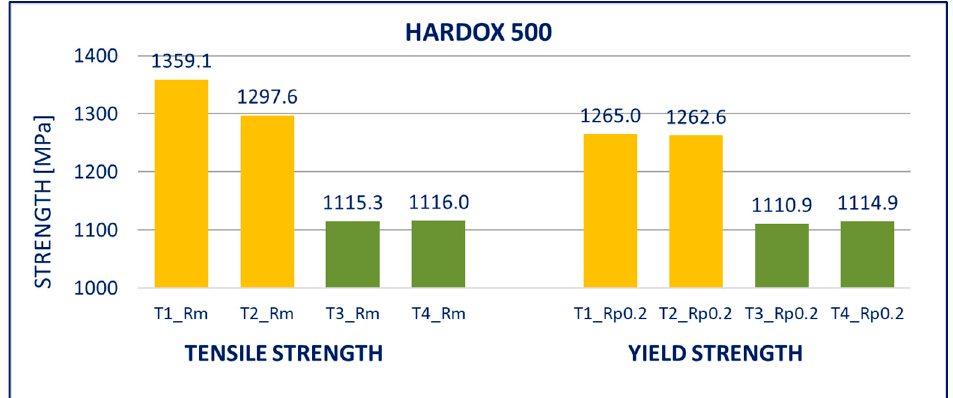
Figure 8. Tensile tests of specimens from HARDOX 500 steel. Description of specimens: T1 and T2 are groups of specimens without zinc coating; T3 and T4 are groups of specimens after hot-dip gal- vanization. R m is tensile strength, R p0.2 is yield strength.